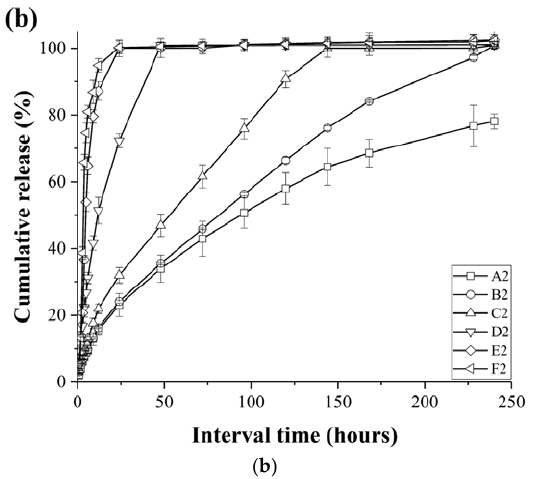
Figure 7. Imiquimod release profiles ( a ) 5 w / w % and ( b ) 10 w / w % for the various PCL nanofibrous mesh samples (A1 to F2) described in Table 2.